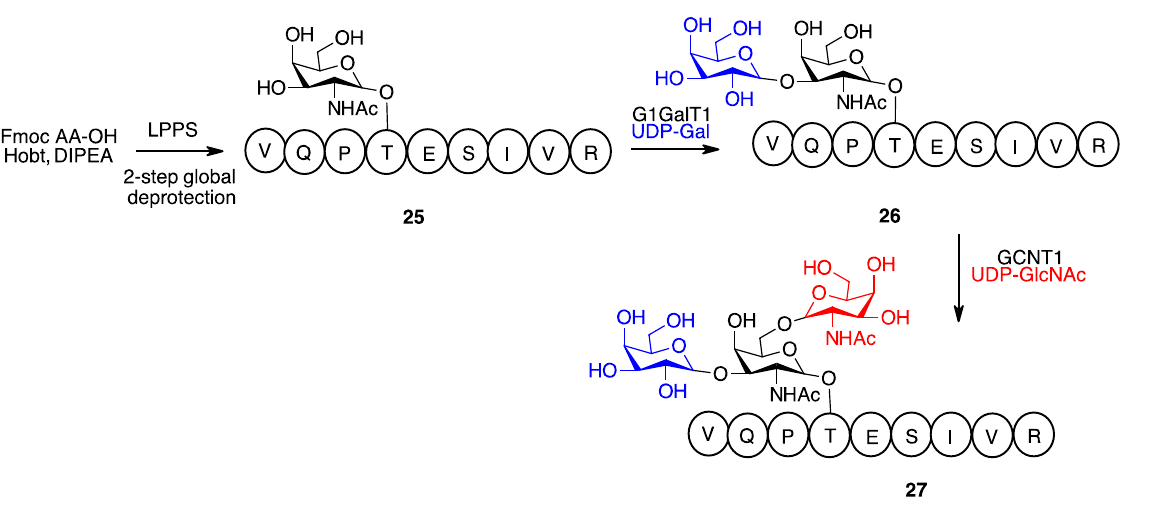
Scheme 9. Enzymatic diversification of core peptide for the synthesis of SARS-CoV-2